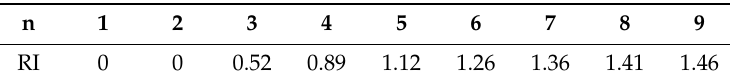
Table 2. Random Consistency Index